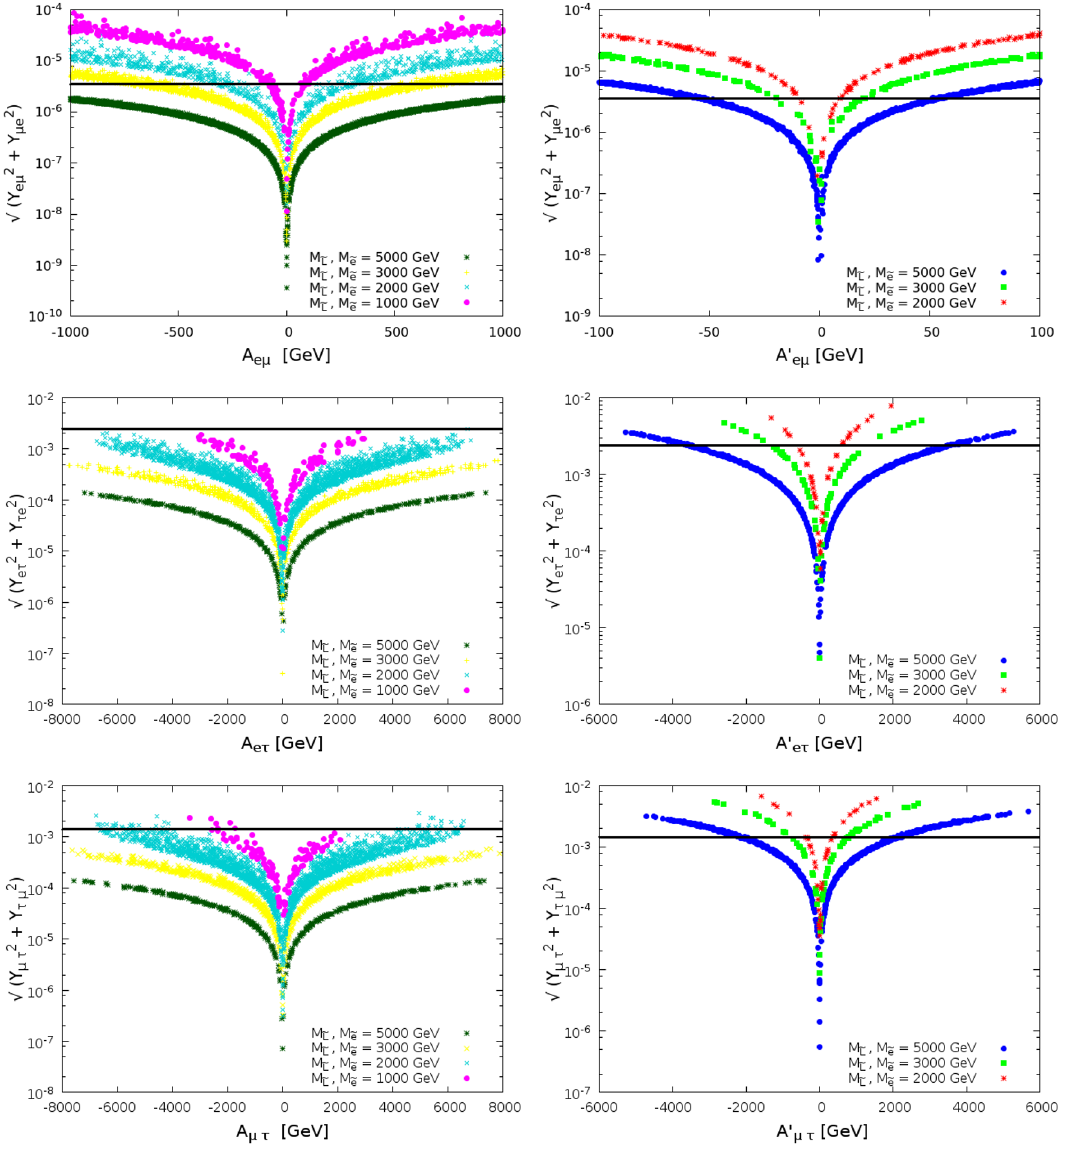
q Figure 12. Y 2 + Y 2 vs. A ij (left panel) and A 0 (right panel) are shown for (cid:12)xed slepton bilinear ij ij ji soft masses and M 1 = 400 GeV. Other (cid:12)xed parameters are as stated in table 3. For holomorphic trilinear couplings, slepton soft masses are (cid:12)xed at 1, 2, 3 and 5 TeV and the same for NH couplings are at 2, 3 and 5 TeV. Black horizontal lines in each plot denote the corresponding upper limits on the o(cid:11)-diagonal Yukawa